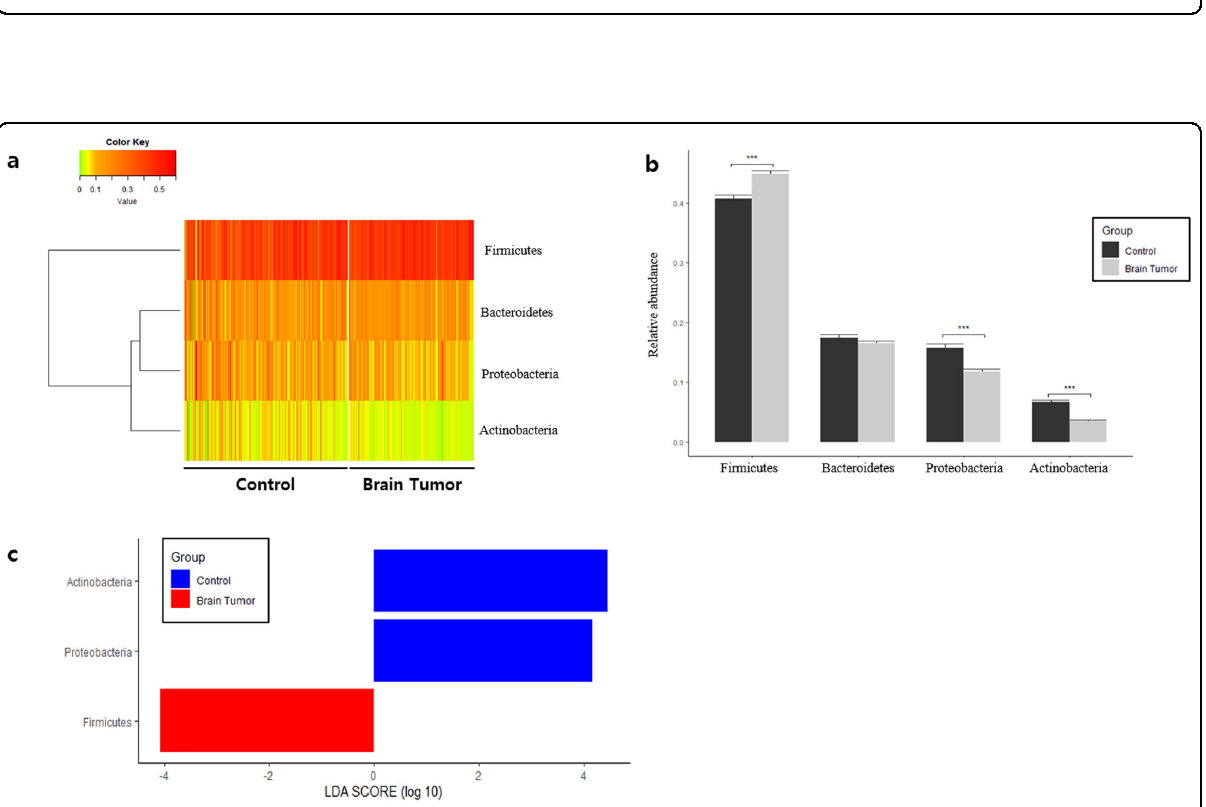
Fig. 1 Alpha and beta diversity of serum in healthy control (HC) subjects and brain tumor (BT) patients. Differences in ( a ) alpha diversity (Chao1, Shannon, and Simpson index) and ( b ) beta diversity of the serum EV microbiome between the HC and BT groups using PCoA based on Bray – Curtis dissimilarity at the genus level.